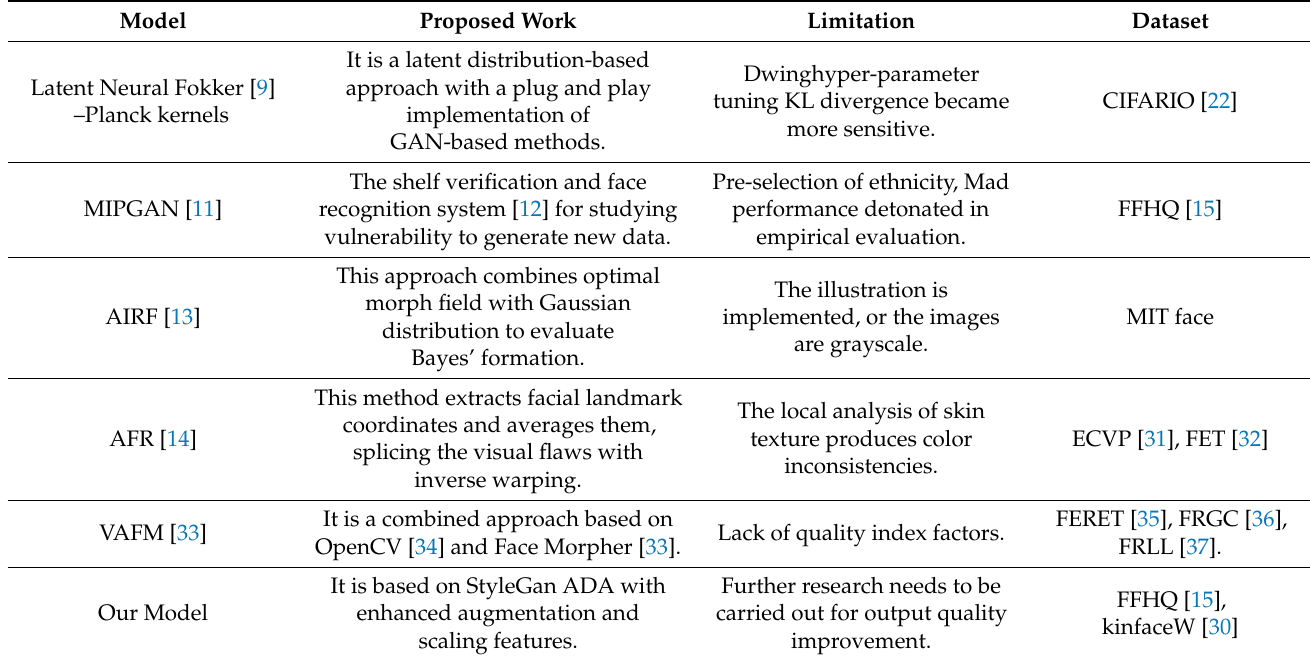
Table 4. Comparison of the proposed work with related models.